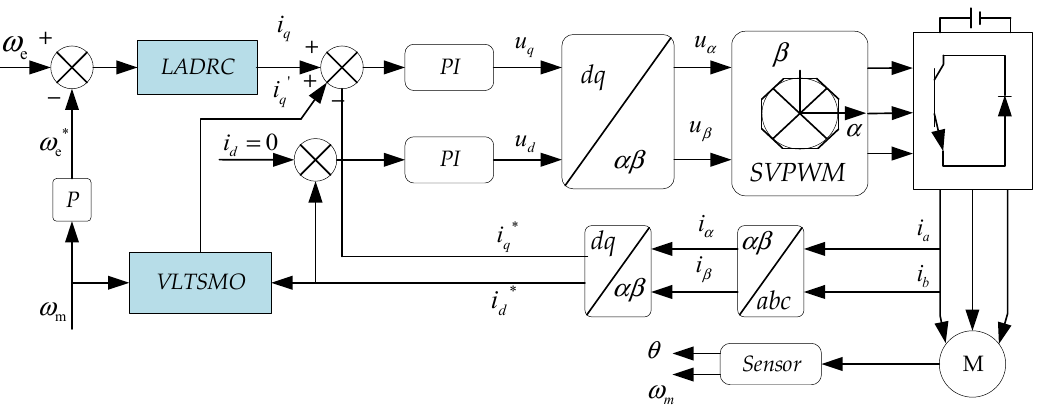
Figure 14. Block diagram of the speed control system.